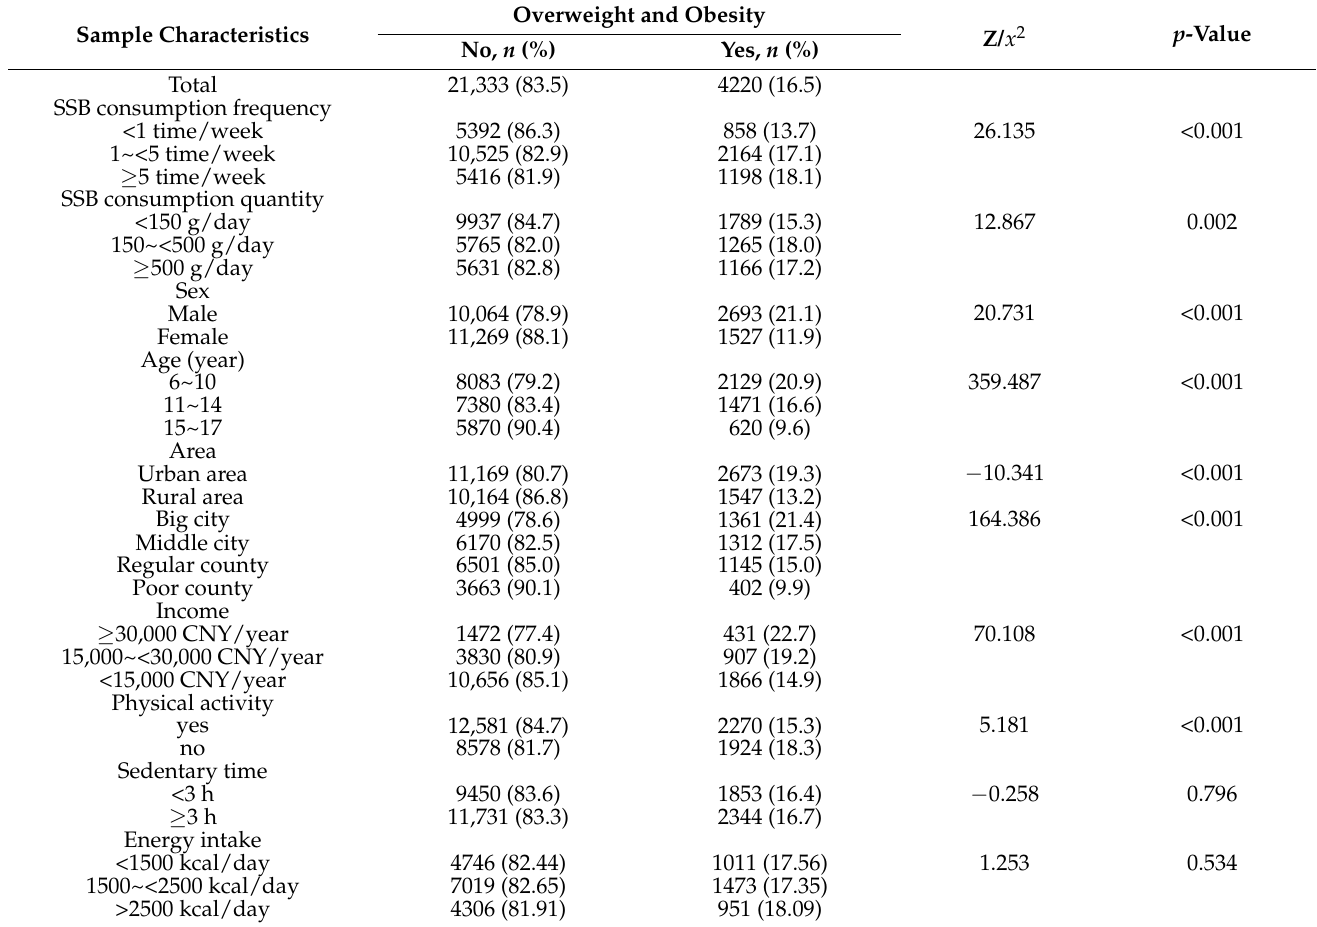
Table 4. Prevalence of overweight/obesity for different groups among Chinese school aged children in 2012 ( n = 25,553). Sample Characteristics